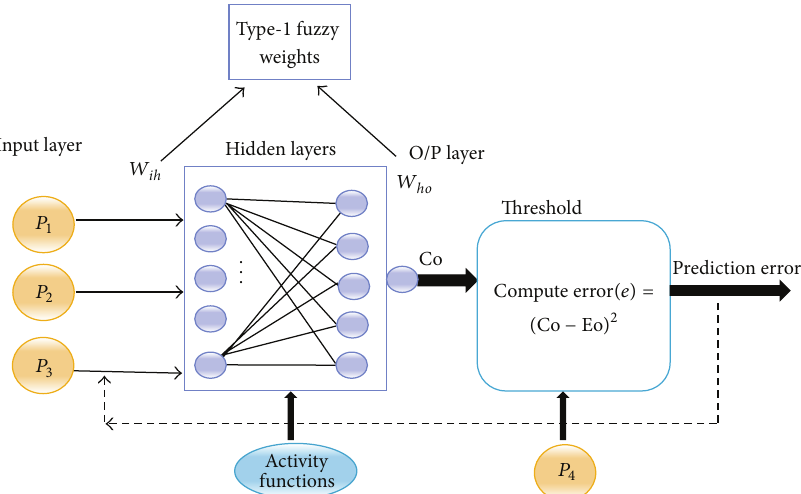
Figure 7: An NN2 (3-5-5-1) architectural